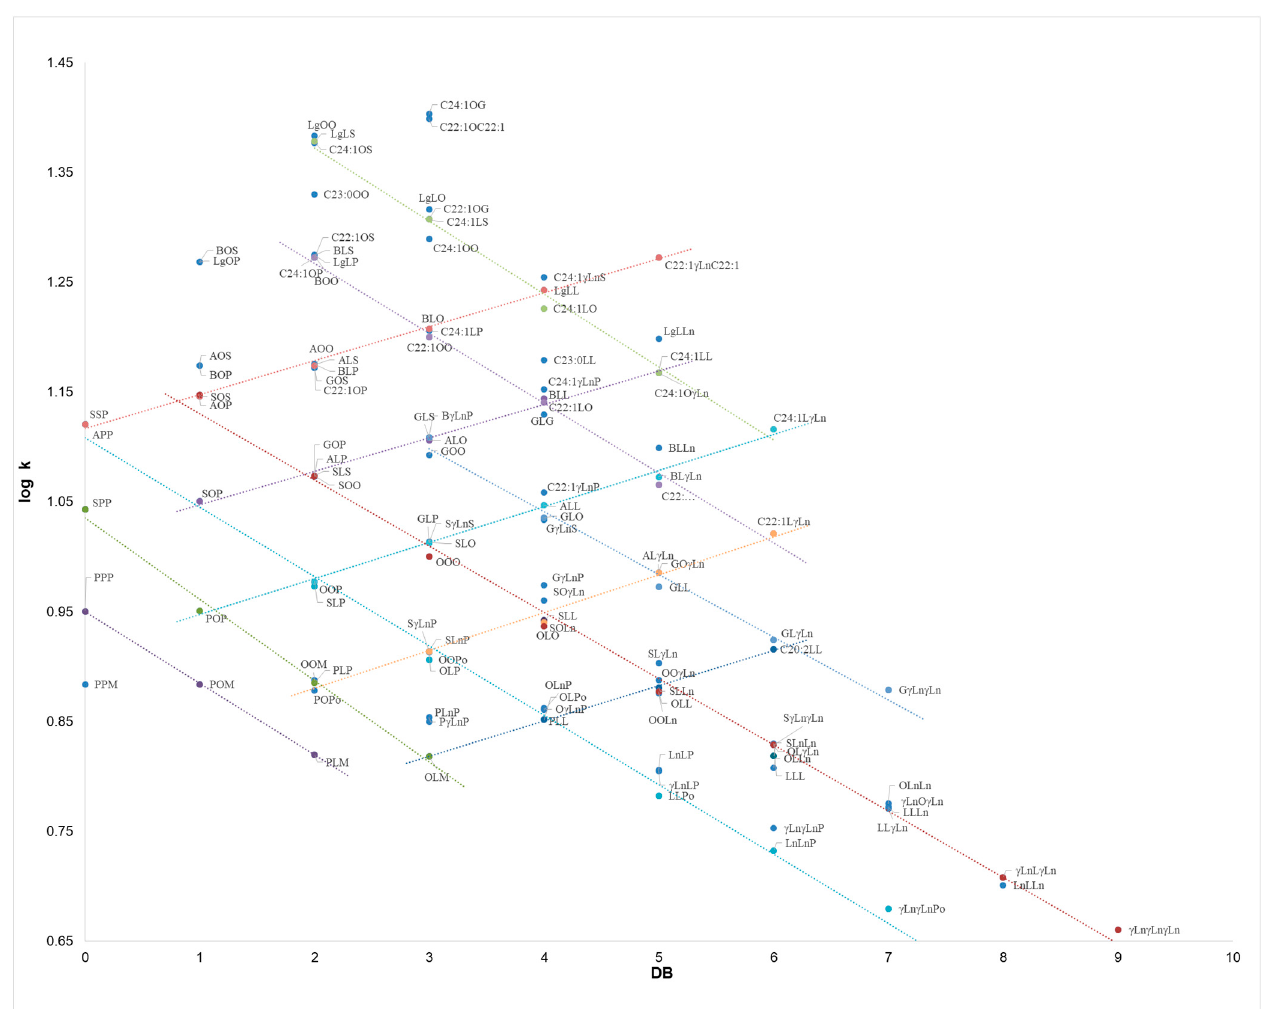
Figure 4. Dependence of log k vs. DB for 121 TAG compounds, as obtained from independent subFC-APCI-MS analyses of seven oil samples: borage oil ( Borago officinalis L.), corn oil ( Zea mays L.), refined hazelnut oil ( Corylus colurna L.), extra virgin olive oil ( Olea europaea L.), palm oil ( Elaeis guineensis L.), peanut oil ( Arachis hypogaea L.), and soybean oil ( Glycine max L.). The parametric equations are reported in the text. TAG notation as in Table 1.